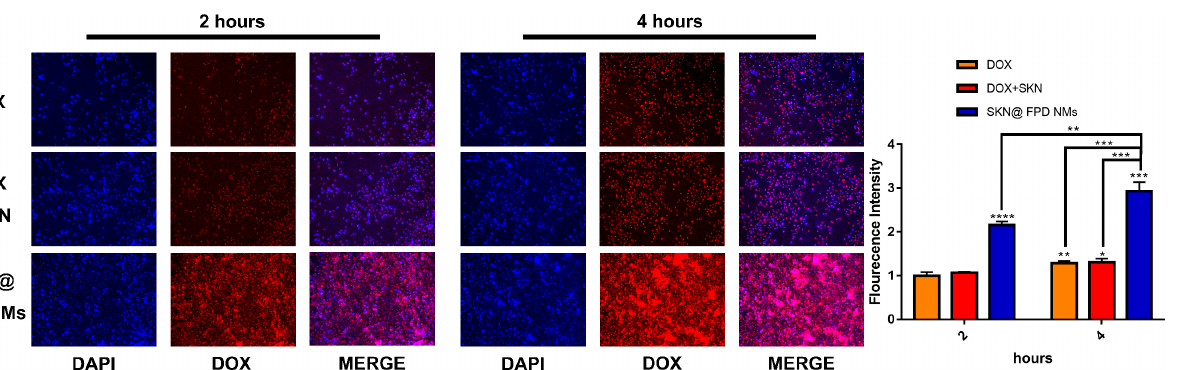
Figure 8. Wound healing experiments using the MDA-MB-231 cells after treatment with DOX, free dual drugs, and SKN@FPD NMs. * p < 0.05, ** p < 0.01, *** p < 0.001. 3. Discussion Currently, monotherapy has been replaced by synergistic therapy due to the low risk of drug resistance, metastasis, and the recurrence of synergistic therapy in triple negative